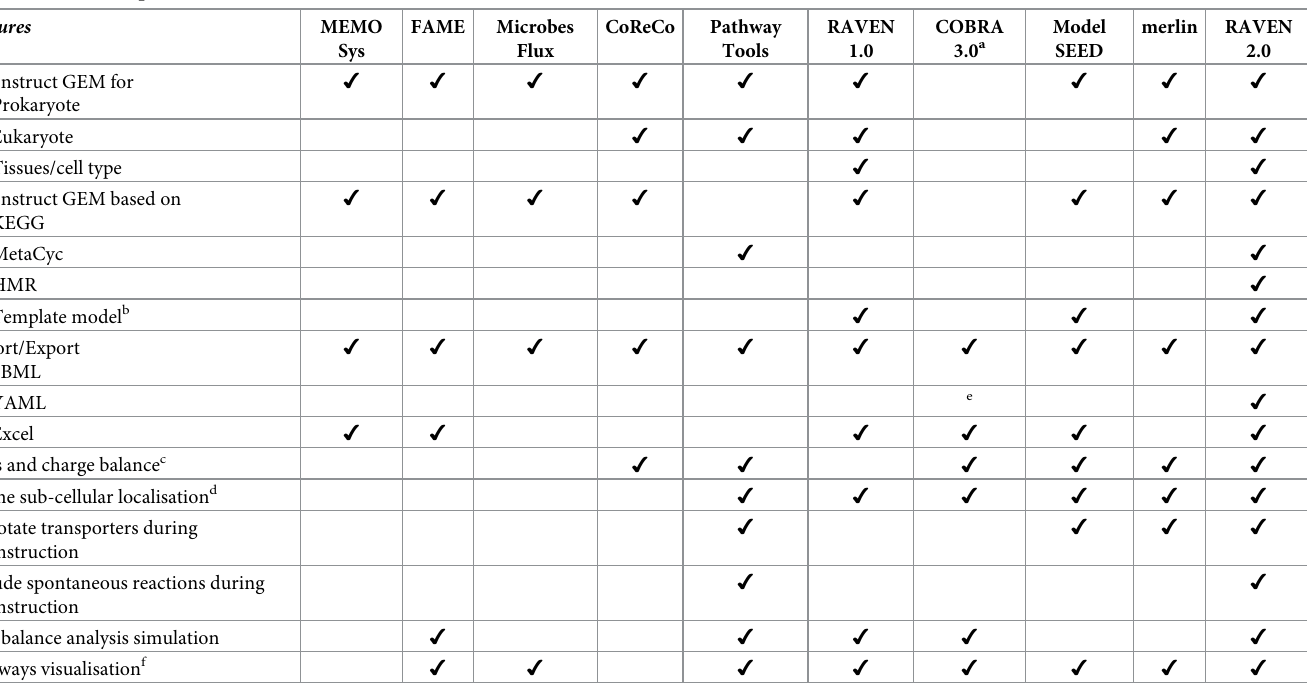
Table 1. Feature comparison of GEM reconstruction